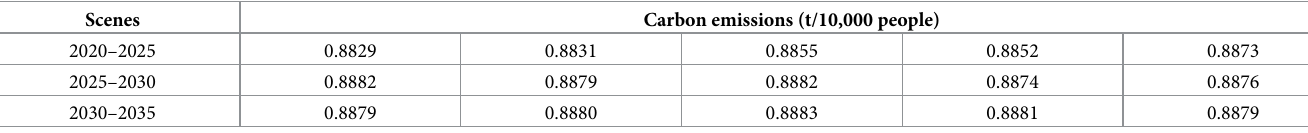
Table 2. Prediction results of Chinese residents’ direct carbon emissions from 2020 to 2035.